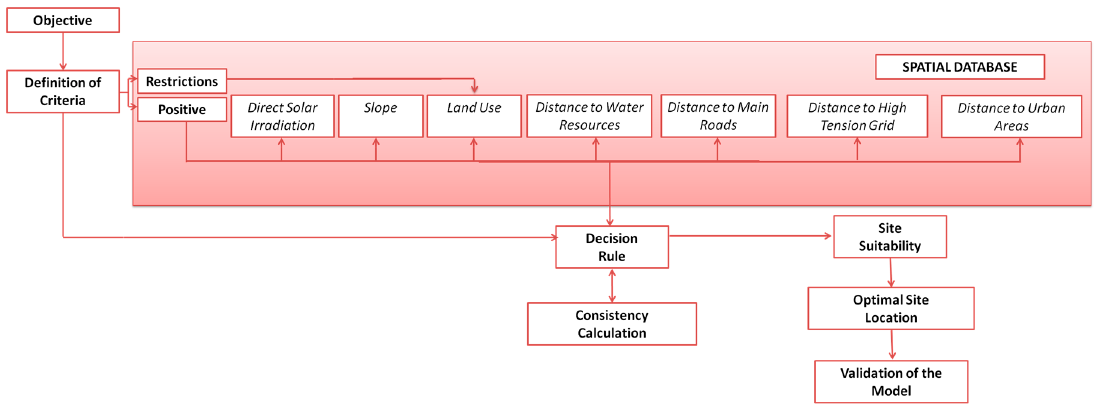
Figure 7. Methodological Procedures Performed for the Location.